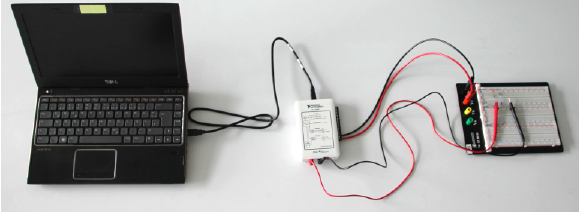
Figure 3. Lecture Theater Laboratory: Experimental